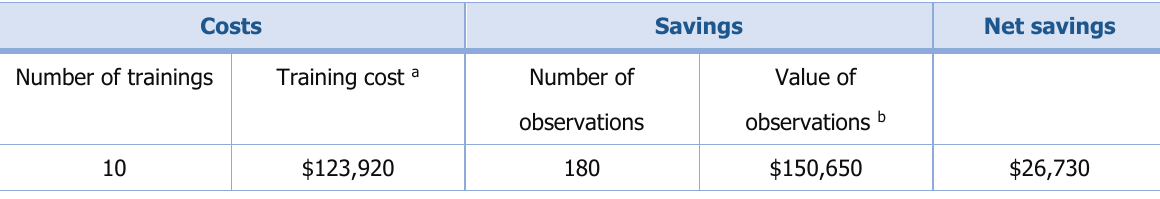
Table 1. Certified Observer Network Net